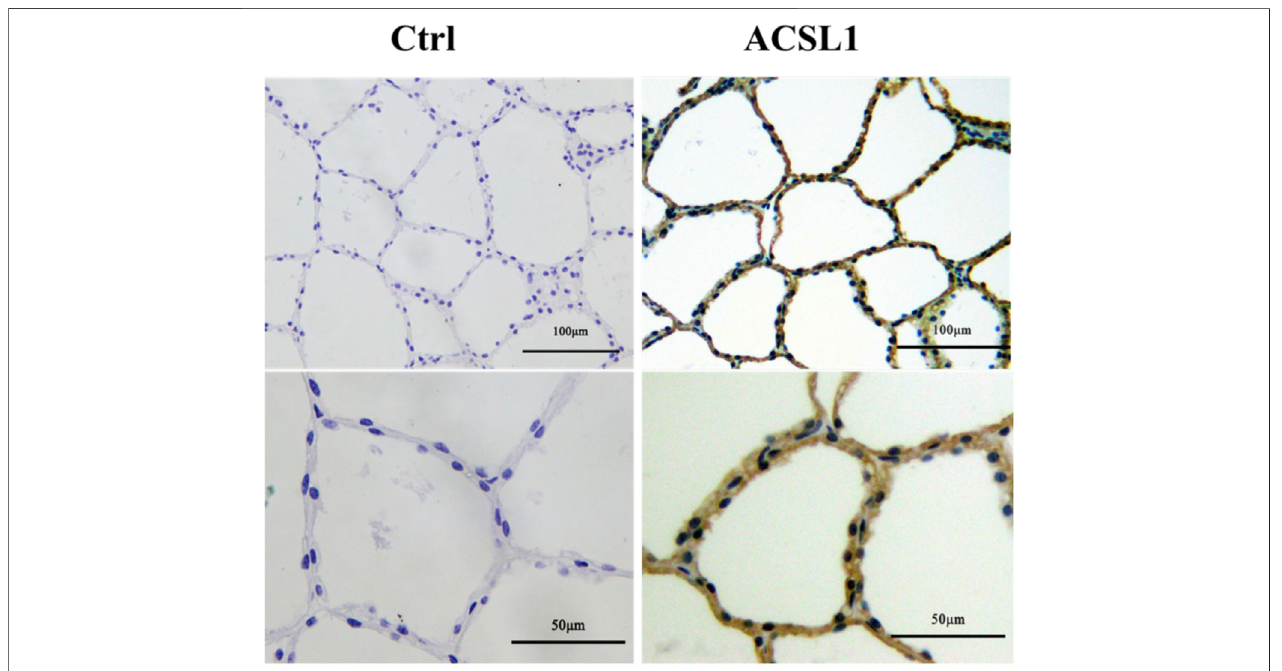
FIGURE 2 | Expression and localization of ACSL1 in buffalo mammary gland. Immunohistochemistry staining of ACSL1 in buffalo mammary gland tissue. The brown color indicated ACSL1 immuno signal, and the nuclei were counterstained in blue. Scale bar: 100 μ m (upper panel, 20 times magni fi cation) and 50 μ m (lower panel, 40 times magni fi